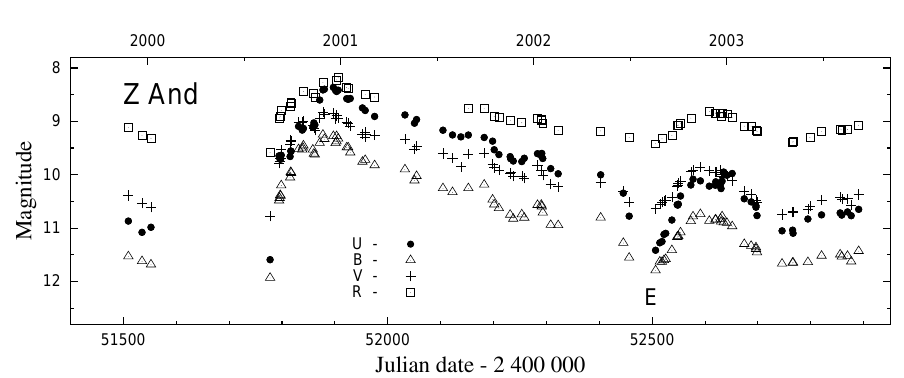
Fig. 1. The recent UBVR light curves of Z